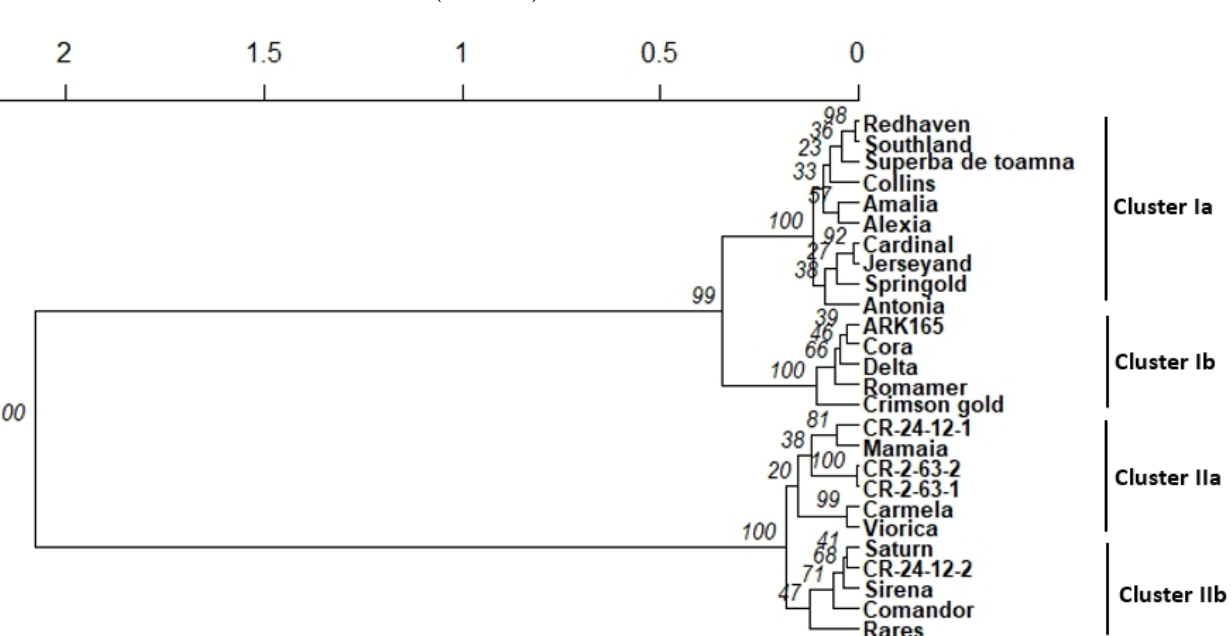
Figure 1. Unweighted pair group method with arithmetic mean (UPGMA) tree based on Nei’genetic distances calculated from 24SSRs. Generated with Poppr v2.8.2 [44].